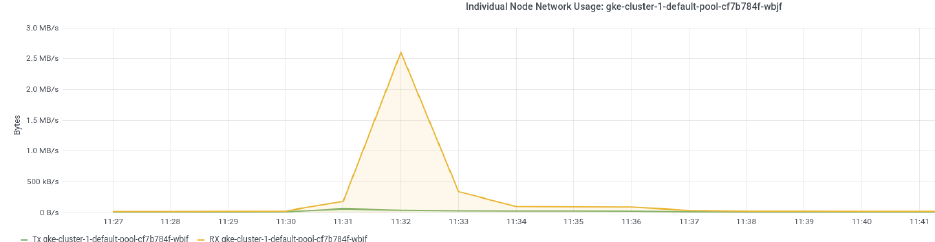
Figure 12. Cassandra node network usage when reconfiguring.